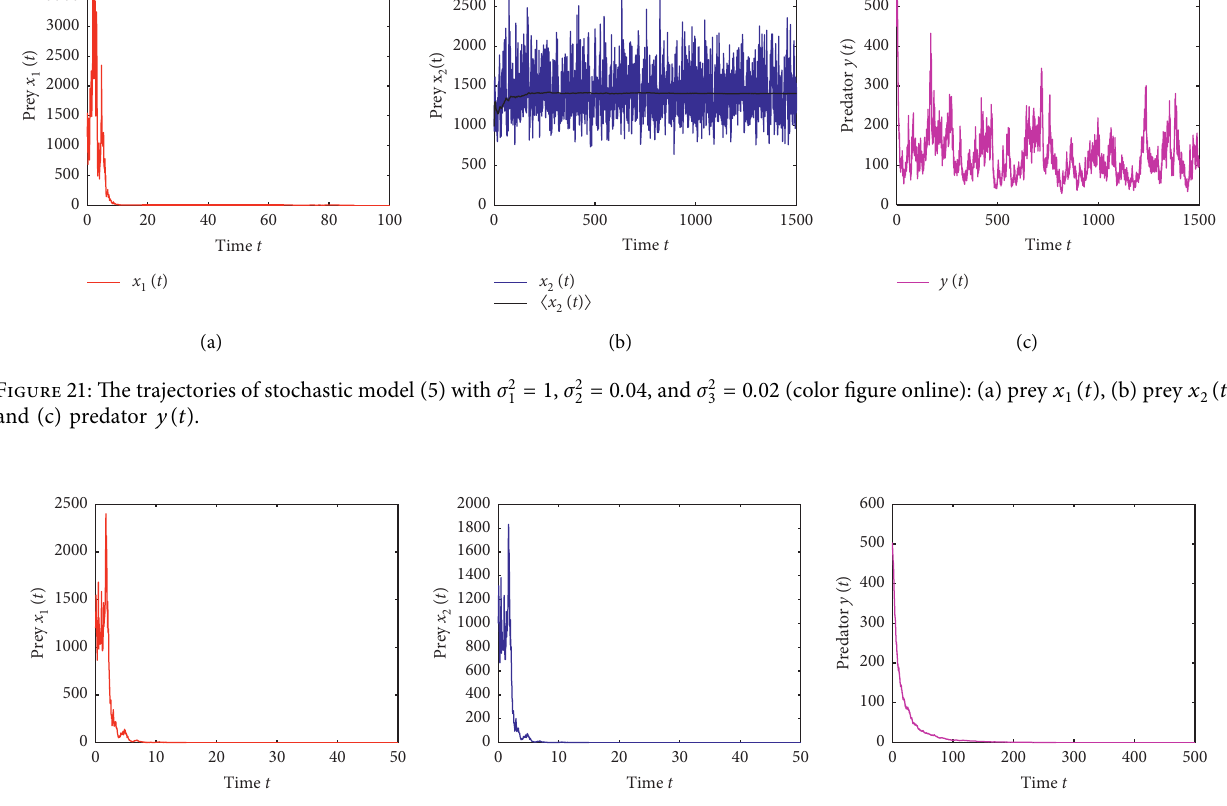
� 1, σ 2 � 1 . 24, and σ 2 � 0 . 002 (color figure online): (a) prey x 1 2 3